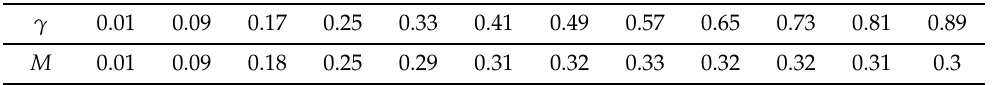
√ √ γ , γ ) and several